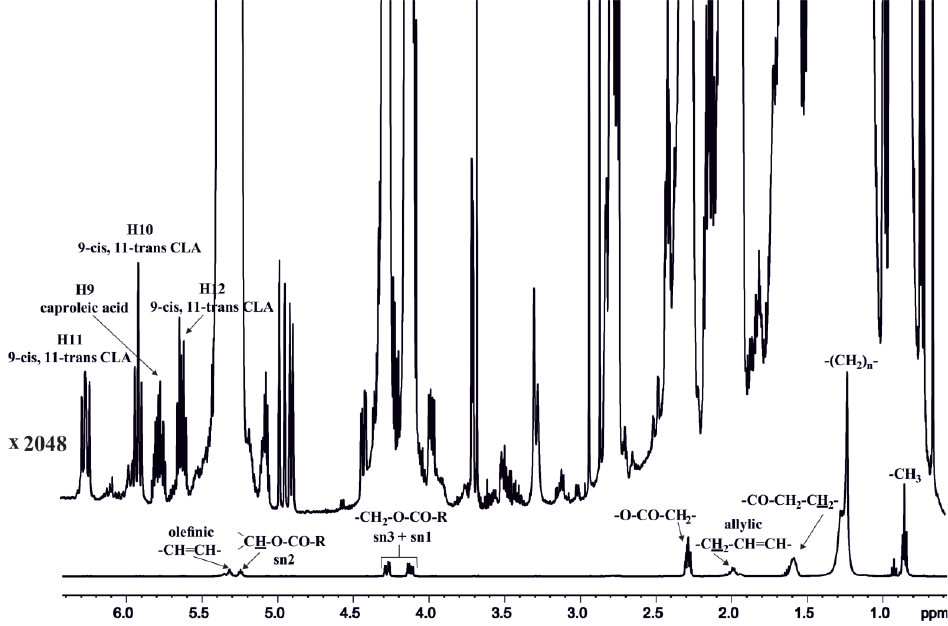
Figure 5. 500 MHz 1 H-NMR spectrum of the lipid extract of a milk sample in CDCl 3 (298 K, acquisition time (AQ) = 4.0 s, relaxation delay (RD) = 3.6 s, total experimental = 1 h 5 min). The inset shows 2048 × magnification of the spectrum in order to display some resonances of the minor species 9- cis , 11- trans , 18:2 CLA and caproleic Table 3. 1 H-NMR chemical shifts of alkenyl protons of some methyl octadecenoates in CCl 4 .